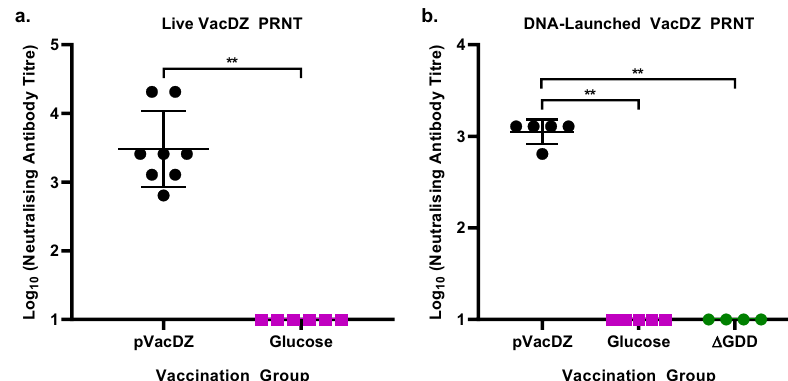
Fig. 4 ZIKV neutralising antibody titres in vaccinated AG129 mice. 5-8 weeks old AG129 mice were inoculated intraperitoneally with the indicated vaccine or control and then boosted four weeks later with the same dose of their respective vaccine or control. Four weeks after boosting mouse serum was harvested. ZIKV neutralising antibody titres were determined using PRNT, and is de fi ned as the highest serum dilution that reduced the ZIKV plaque count by at least 50% in three technical replicates. Each point represents the neutralising antibody titre for one mouse. a PRNT for AG129 mice vaccinated with live VacDZ (10,000 PFU per mouse, n = 8) or PBS vehicle control ( n = 6). b PRNT for AG129 mice vaccinated with DNA-launched VacDZ (pVacDZ, 80 μ g of pVacDZ and 20 μ g of pTet-Off Advanced per mouse, n = 5), 5% glucose solution vehicle control (glucose, n = 5), or pVacDZ- Δ GDD replication defective mutant ( Δ GDD, 80 μ g of pVacDZ- Δ GDD and 20 μ g of pTet-Off Advanced per mouse, n = 4). Statistical analysis was performed using one way ANOVA, and post-hoc analysis was performed using Tukey HSD. Statistical signi fi cance: *, P < 0.05; **, P < 0.01; ***, P <